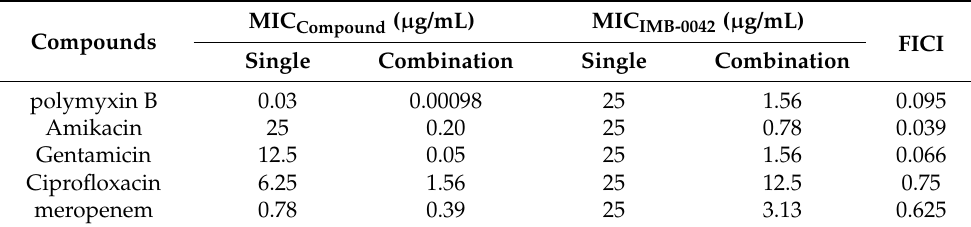
Table 2. The synergetic effect of IMB-0042 with other antibiotics against E. coli ATCC 25922. MIC Compound ( µ g/mL) Compounds